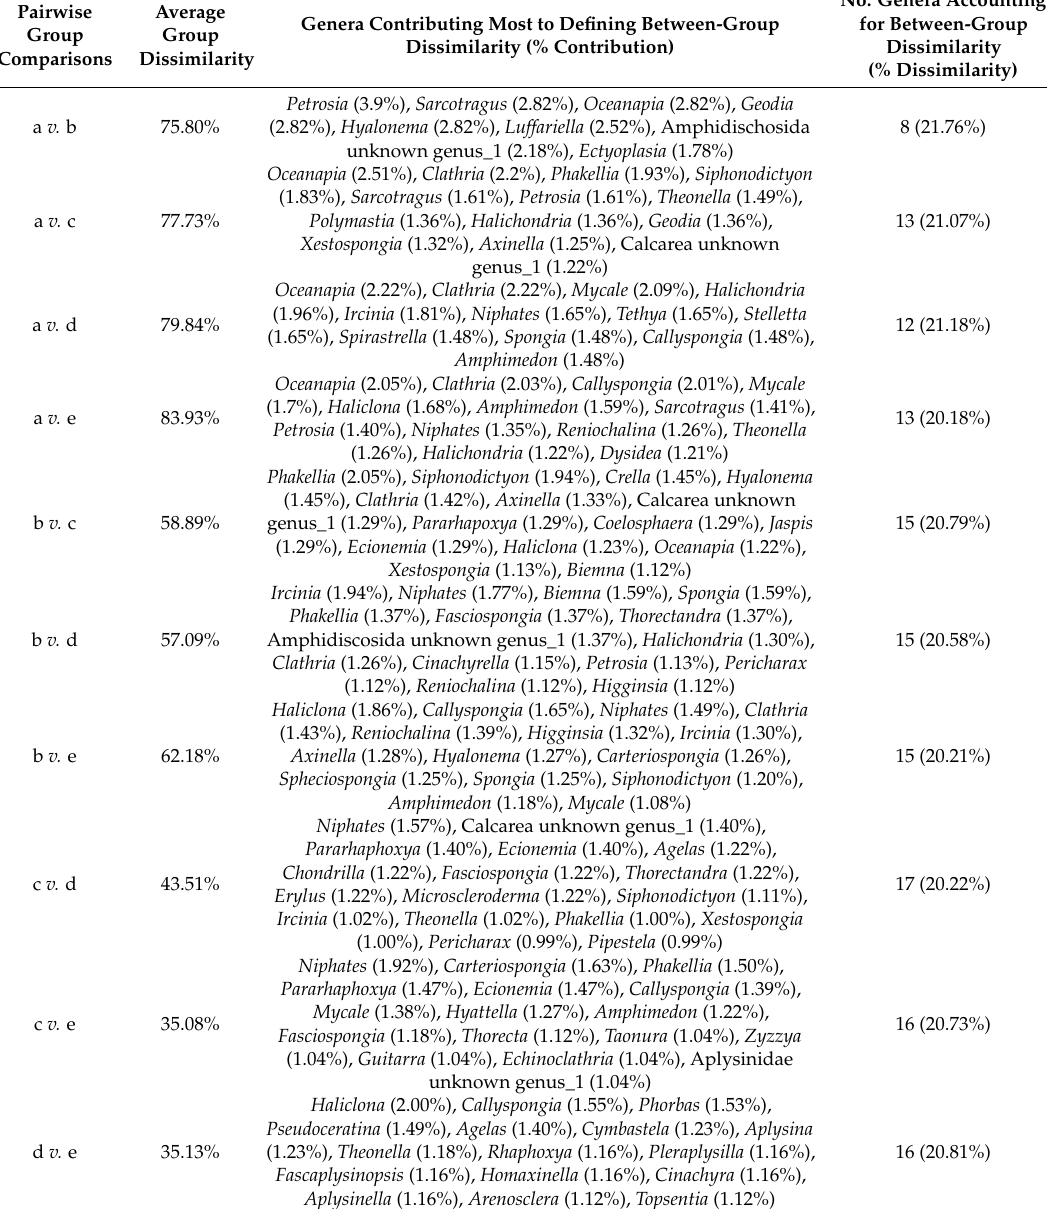
Table 4. Summary of pairwise similarity percentage (SIMPER) analyses between statistically relevant groups of sponges as reflected by cluster, MDS and SIMPROF analyses (see Figures 5b and 6b). Each pairwise group comparison ranks genera according to the overall percentage contribution each makes to the average between-group dissimilarity. Only genera adding to cumulative contributions totaling more than 20% are shown in this table (see Supplementary Table S3 for details of